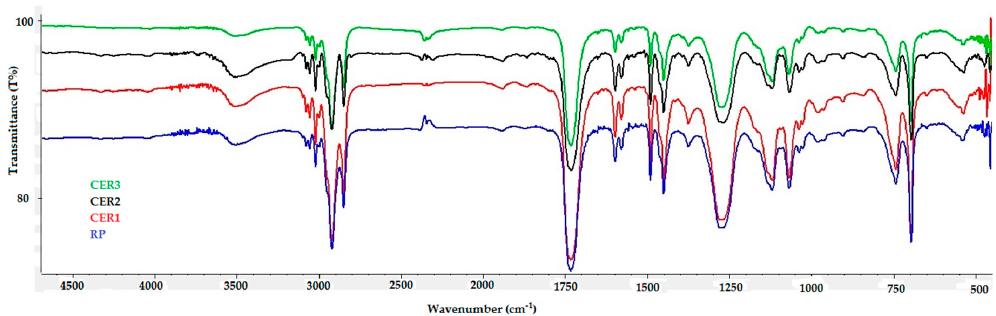
Figure 1. Fourier transform infrared spectroscopy (FTIR) spectra of resins of prepared coatings.